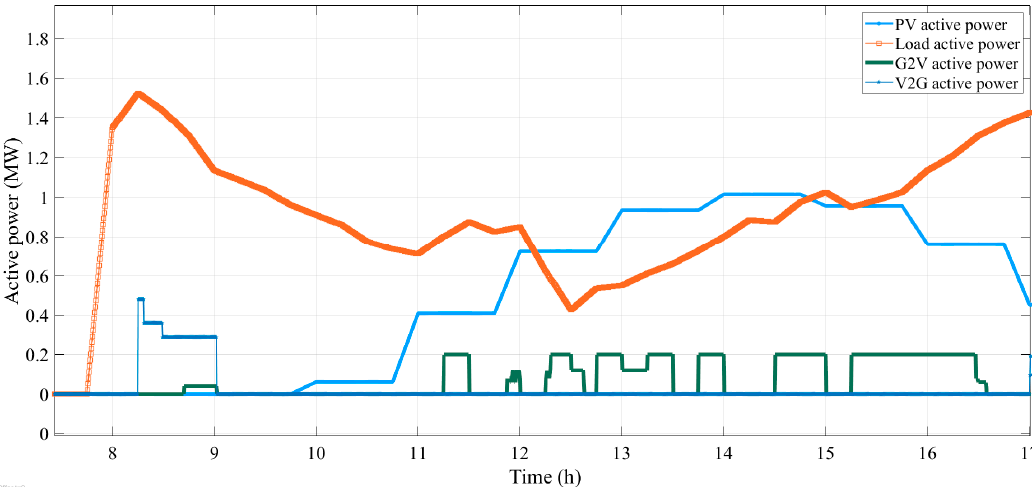
Figure 15. Active power flow of scenario B from 7 a.m. to 17 p.m.